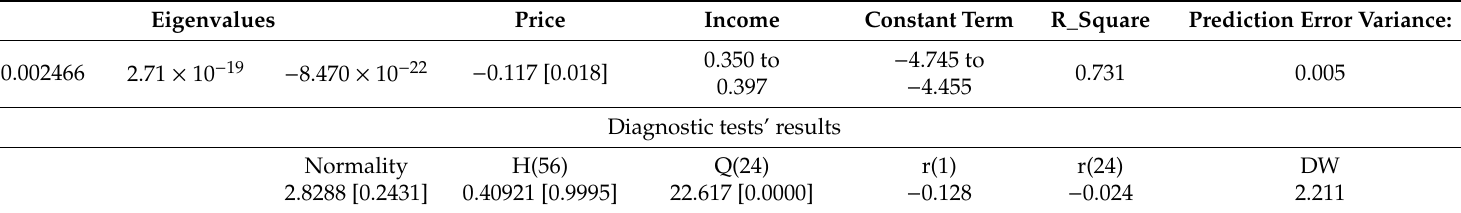
Table 6. STSM long-run estimation results.